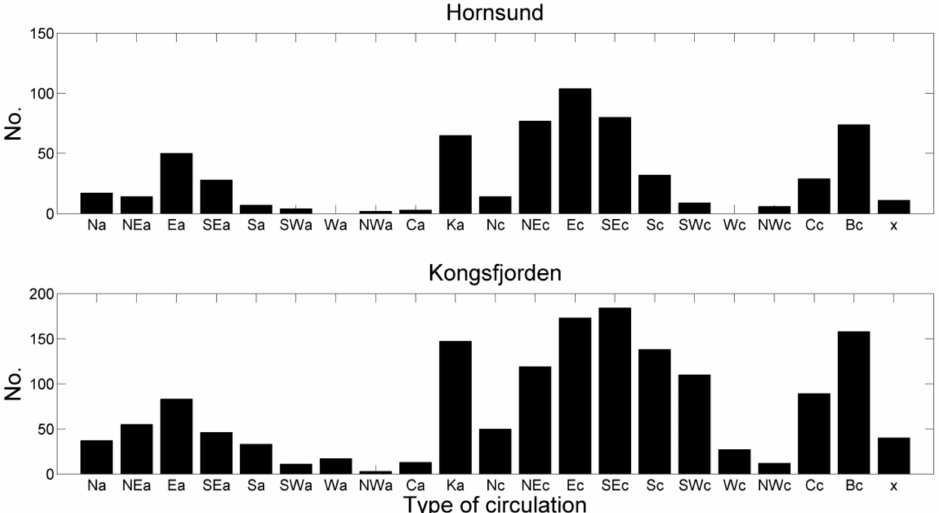
Figure 10. Distribution of types of synoptic situations (circulation types) when the mesoscale effect was recorded in Hornsund and Ny-Ålesund on the basis of the difference in wind directions in West Spitsbergen fjords, but with temperature over open water being lower than over